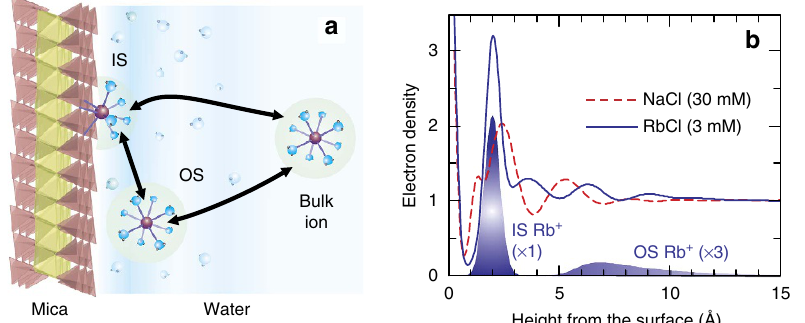
Figure 1 | Monovalent cation exchange and interfacial structure at the muscovite mica (001)–water interface. ( a ) Schematic of the EDL at the muscovite–water interface. Monovalent cations adsorb as a combination of partially hydrated IS and fully-hydrated OS complexes, with several potential pathways for exchange between the adsorbed and bulk solution species. ( b ) Interfacial structure between the mica (001) surface and 30mM NaCl versus 3mM RbCl solutions 22,56 . The total electron-density profiles determined by high-resolution XR are shown for the two solutions. The distribution of IS and OS Rb þ determined by RAXR is shown in shaded areas. The height is referenced to the average height of oxygen in the mica surface. The distribution of OS Rb þ is scaled vertically by a multiplicative factor of 3 for